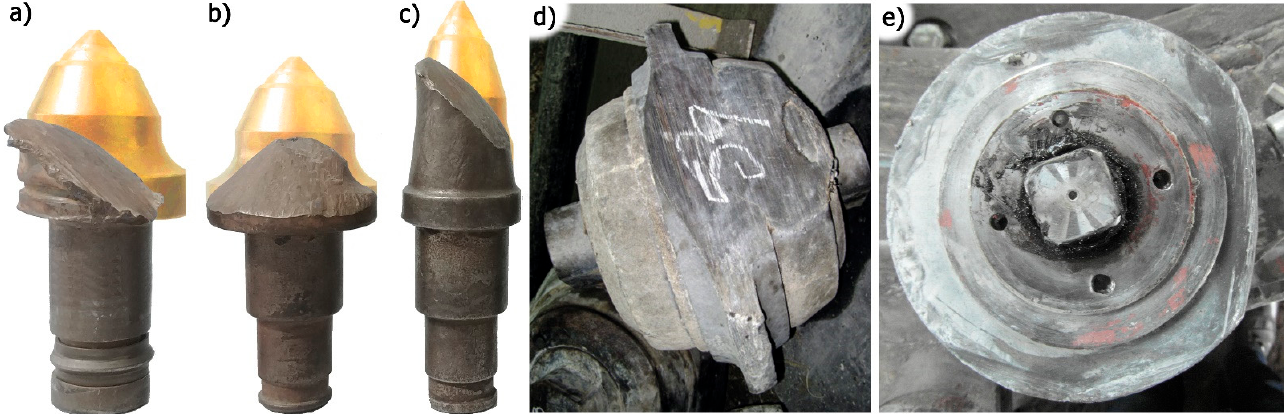
Figure 4. Examples of excessively worn tools: ( a – c ). conical picks (the shape of the new pick has been marked in colour) [30], ( d ). symmetrical disk [32], and ( e ). asymmetric disk [31].